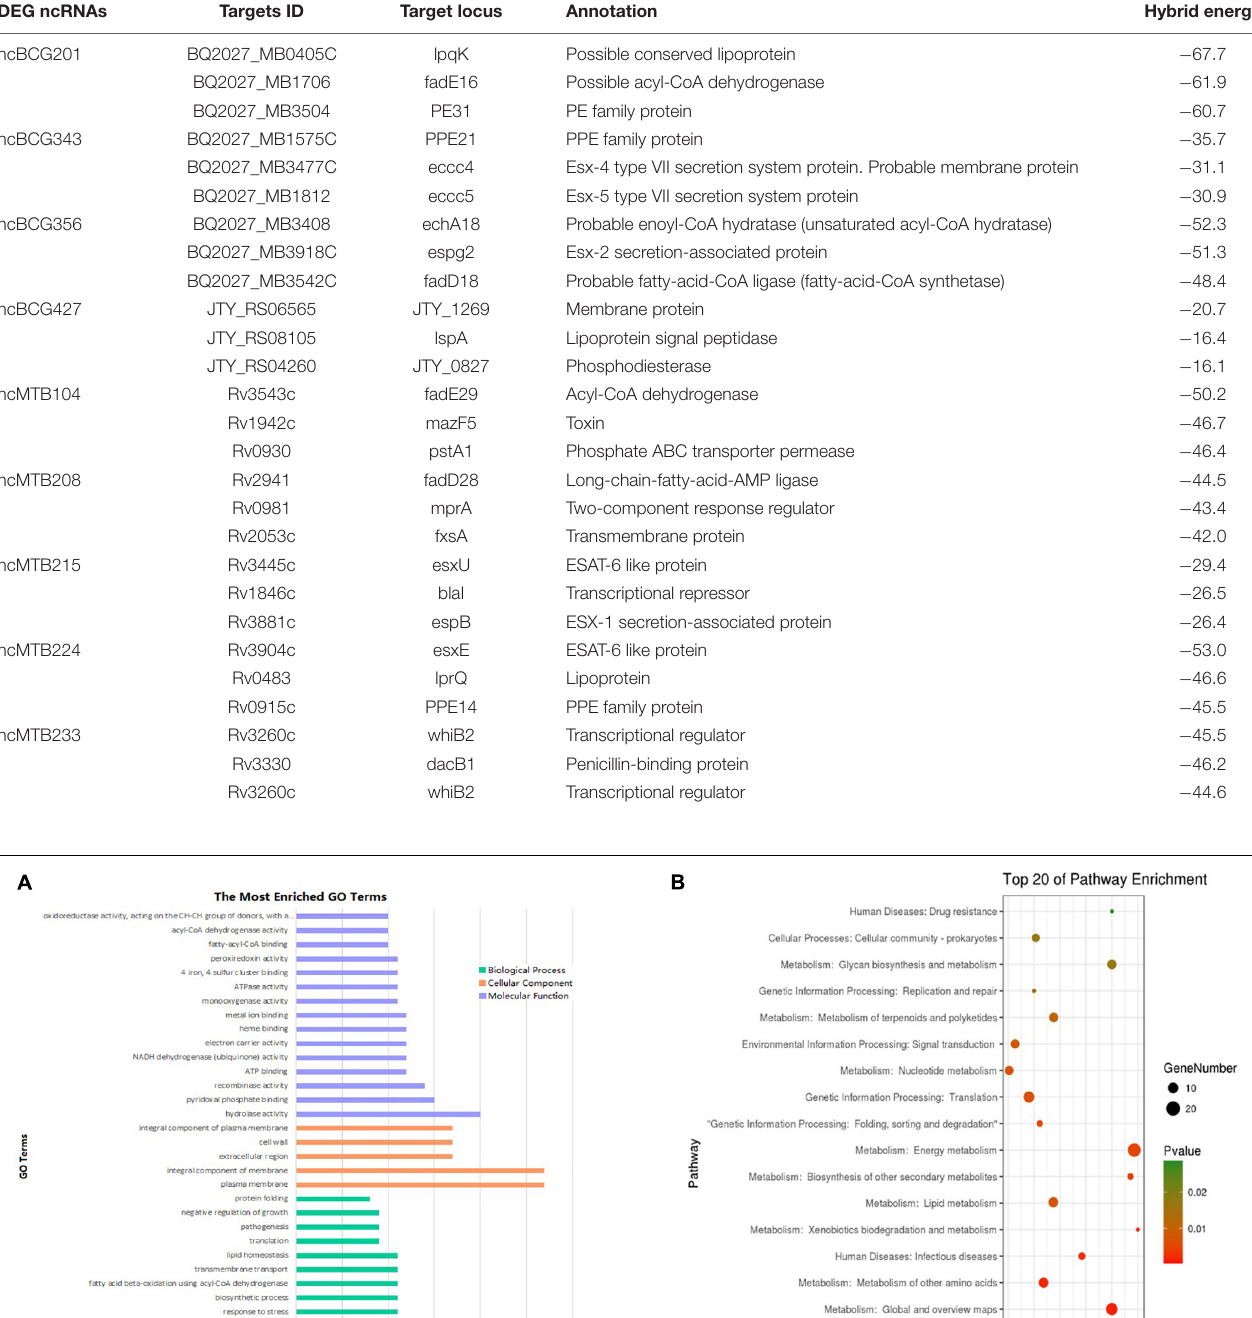
TABLE 1 | Important target genes of some differentially expressed ncRNAs.